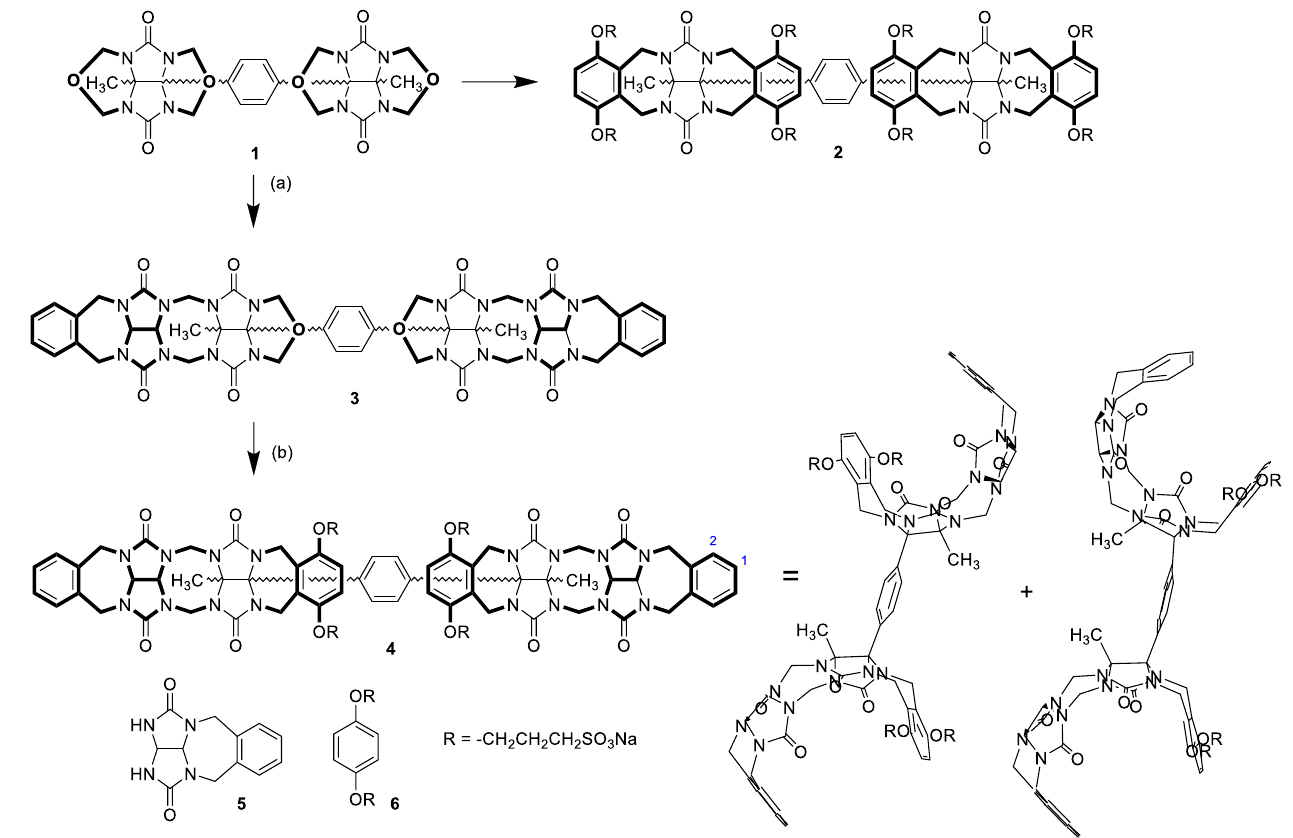
Figure S20. Reaction conditions: ( a ) 5 , MeSO 3 H, 60 ◦ C, 4 h, 72%; ( b ) 6 , TFA/Ac 2 O, 95 ◦ C, 3 h,